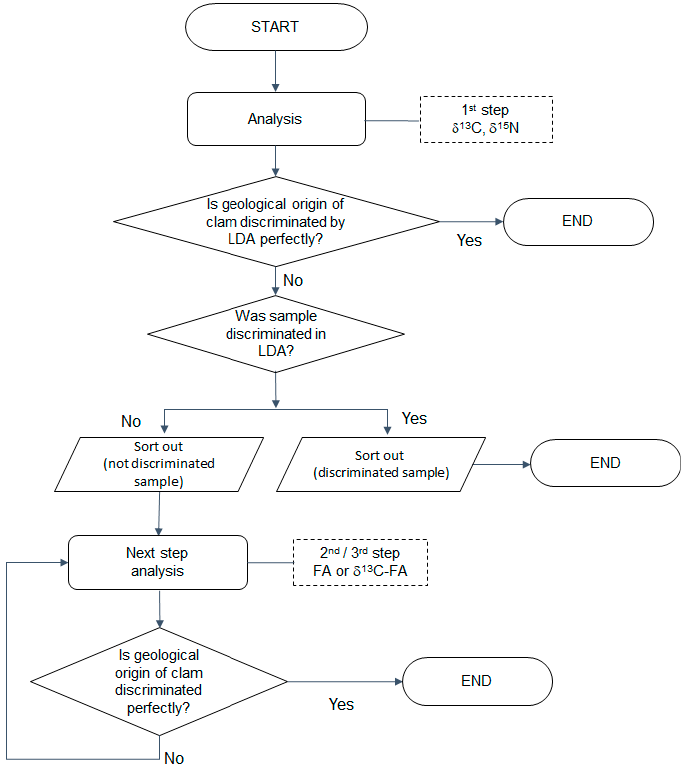
Figure 1. A schematic flow diagram of stepwise application of dual-element stable isotope analysis, fatty acid composition (FA), and compound-specific isotope analysis (CSIA) of FAs ( δ 13 C-FA). This process enables the collection of geographic information included in each parameter and application of this information for determining geographical origin.